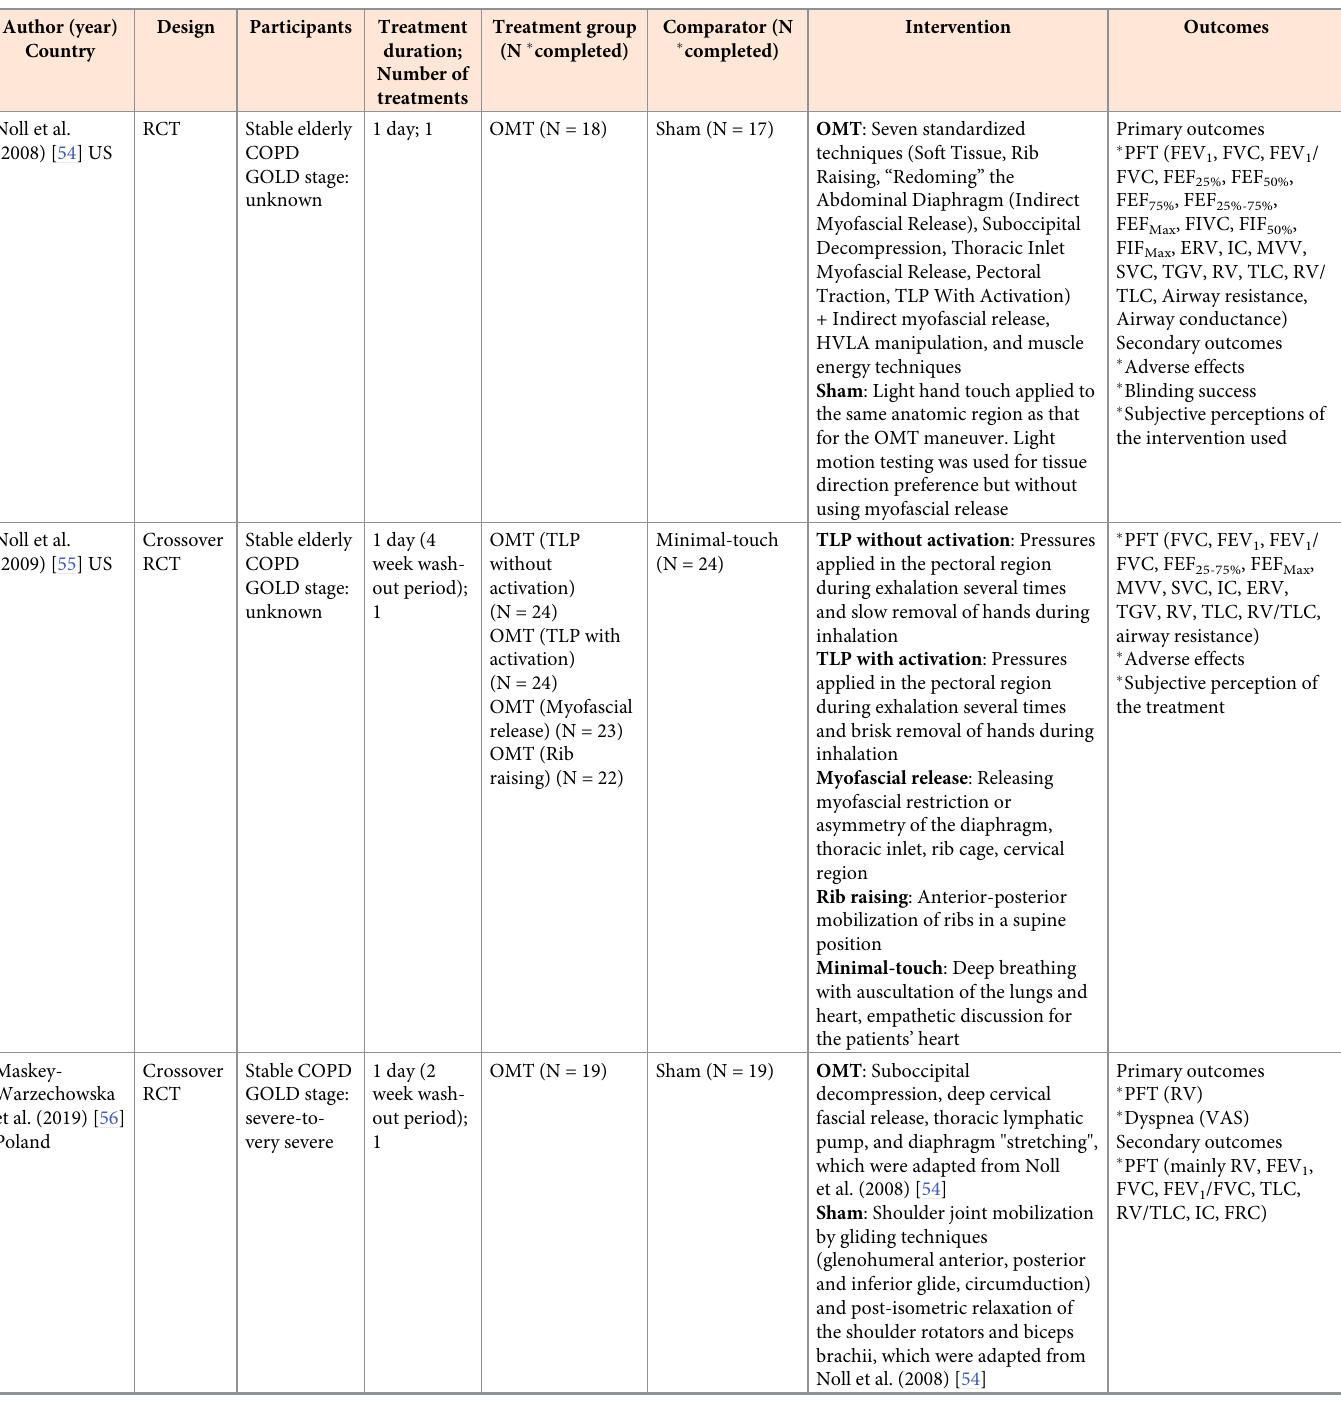
Table 1. Characteristics of the included studies.